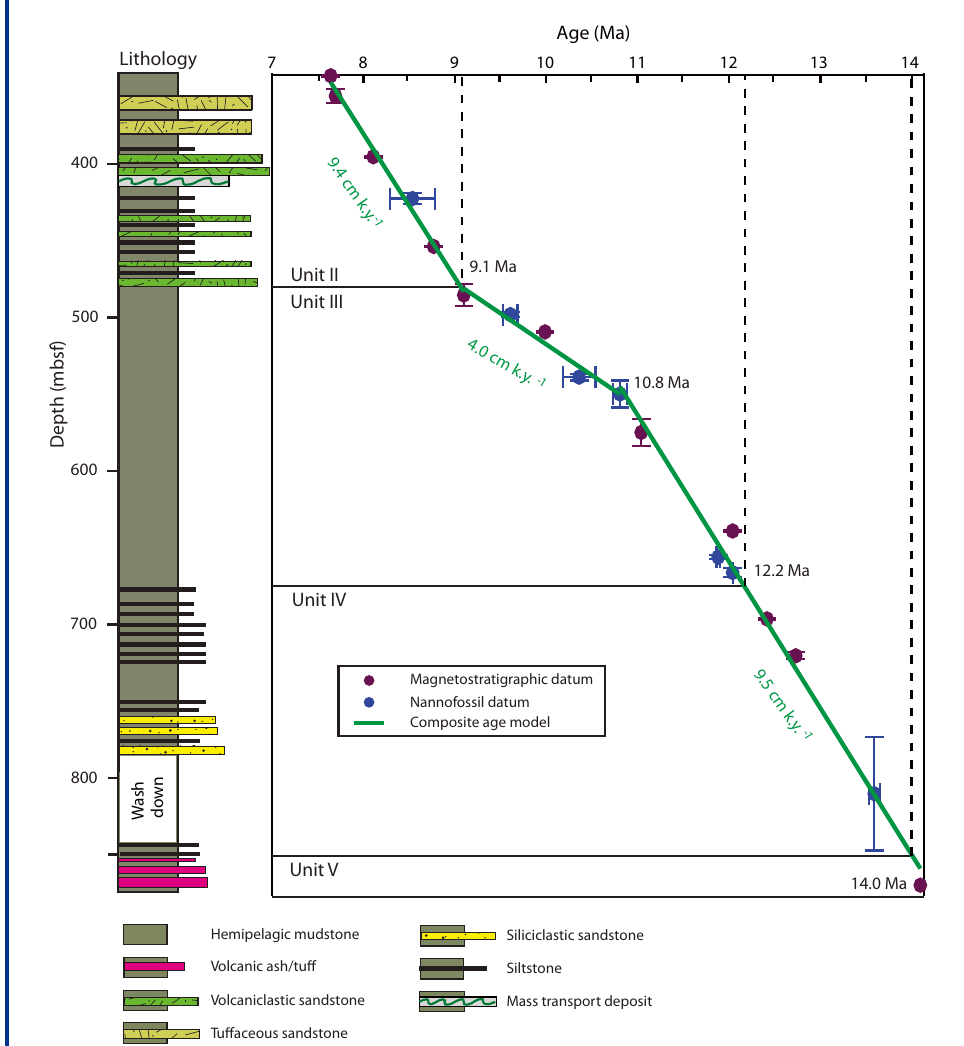
SiltstoneHemipelagic mudstone Volcanic